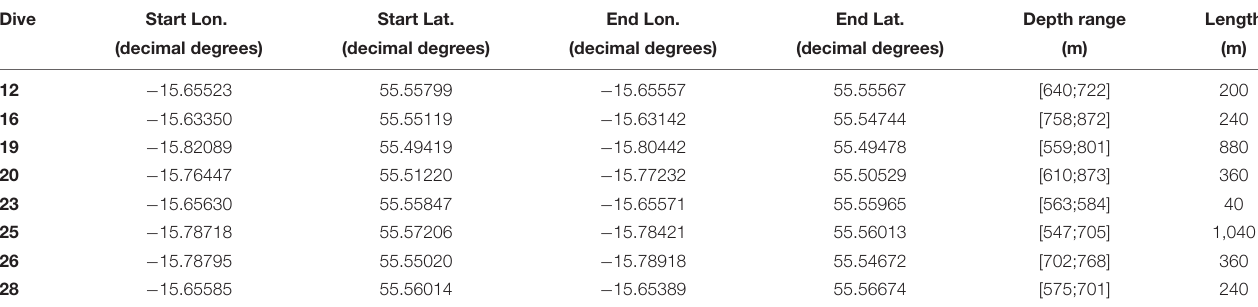
FIGURE 1 | (A) The location of the high-definition ROV video transects in the Logachev Mound Province, (B) the red square indicating the location of the Logachev Mound Province on the southeast shelf of Rockall bank, and (C) a zoomed-in map showing the location of the ROV video transects. TABLE 1 | Dive number, location [longitude (Lon.) and latitude (Lat.)], depth range (m), and length (m) of ROV video